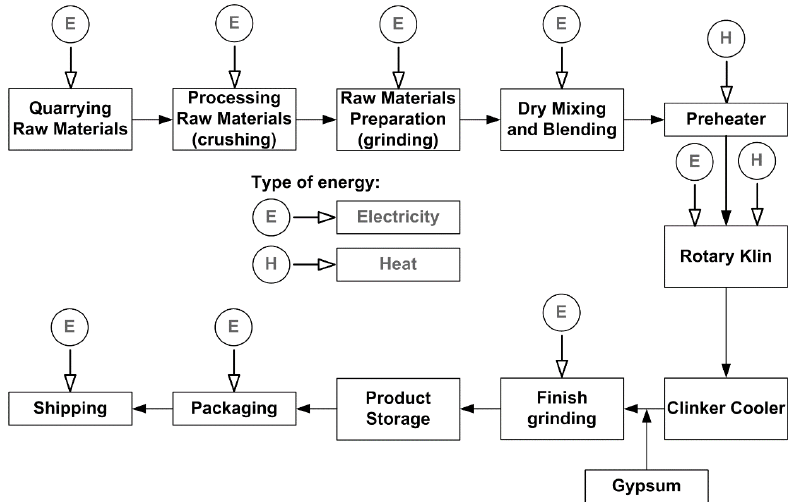
Figure 4. Process flow diagram for the cement manufacturing process, showing electricity and heat consumption or inputs